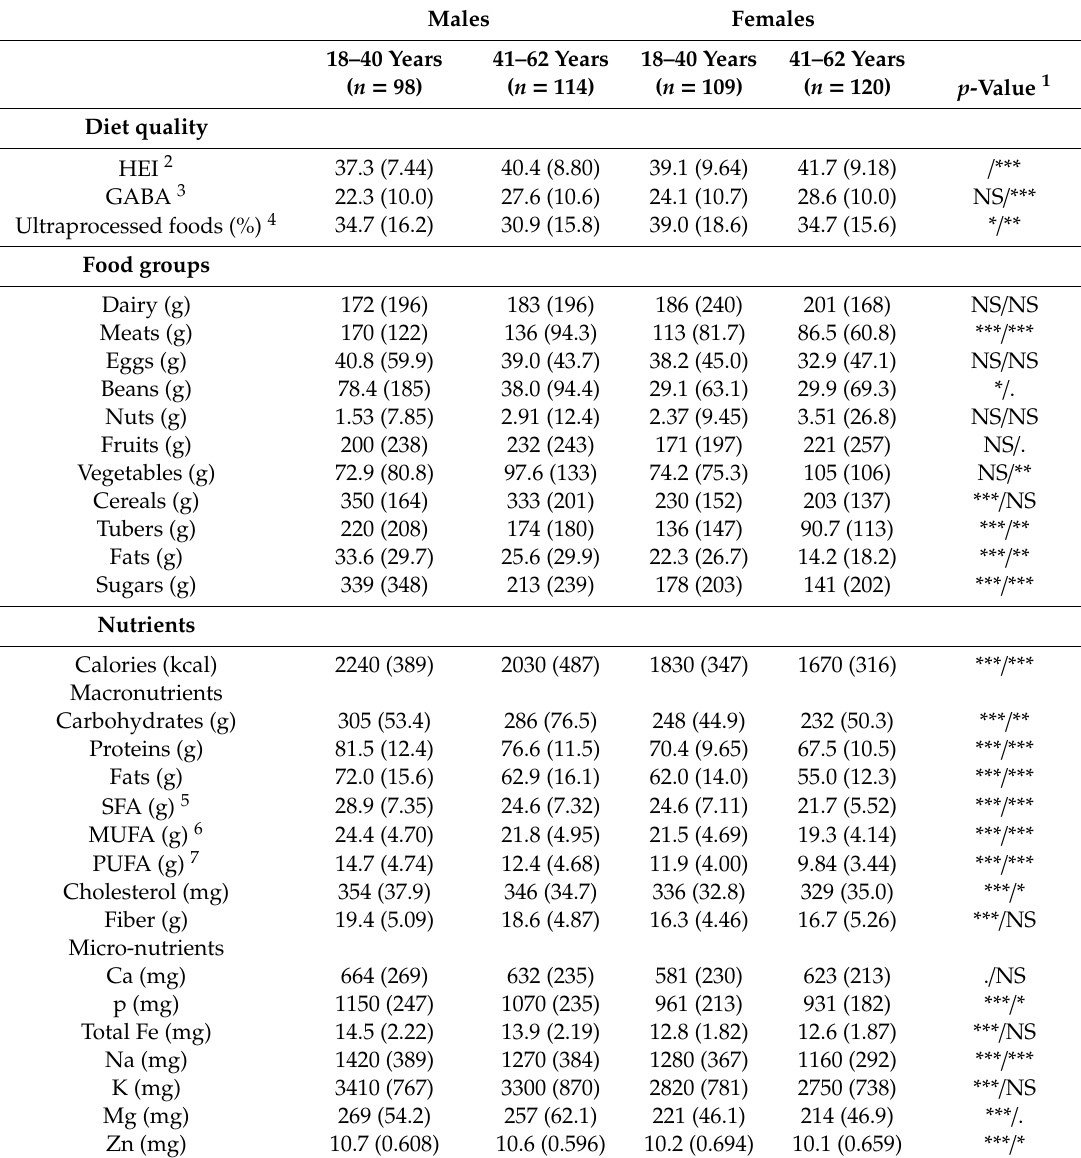
Table 1. Diet intake in the studied population grouped by sex and age group. Average and standard deviation values (within parentheses) are